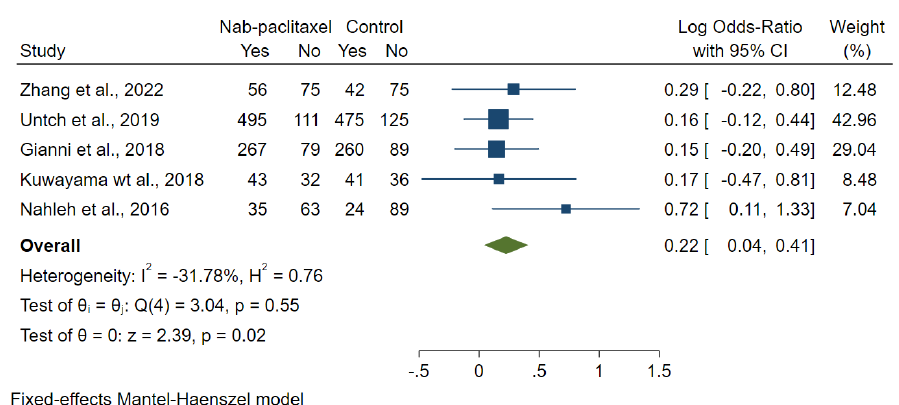
Fig. 3. The Forest plot showed the Overall response rate in breast cancer